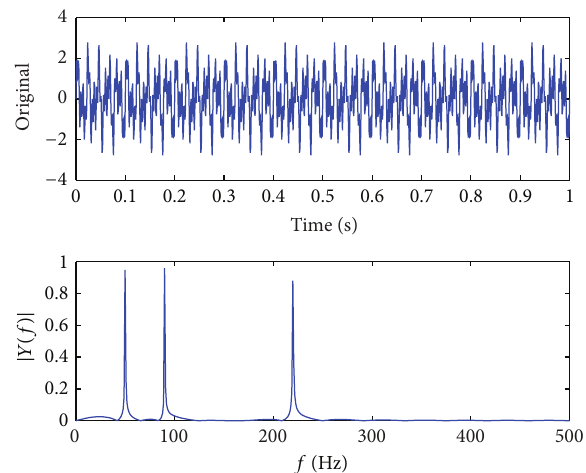
Figure 2: Time-domain waveform of simulation signal 𝑥(𝑡) and the frequency